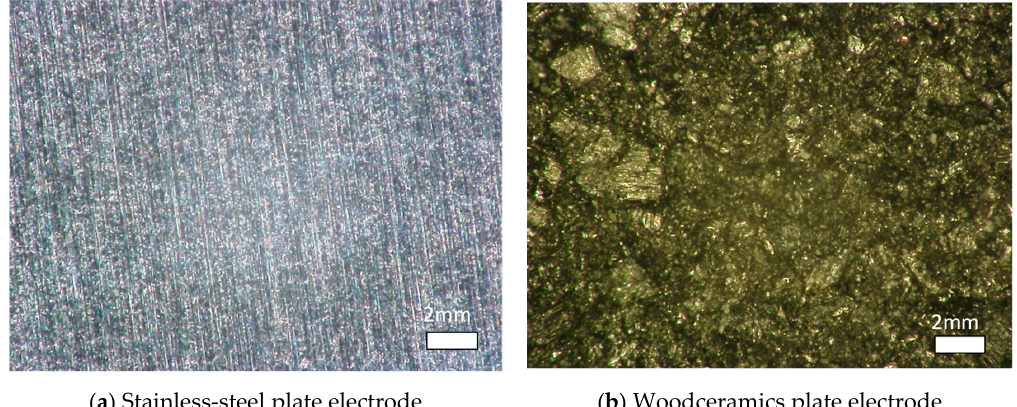
Figure 6. ( a ) Stainless-steel surface and ( b ) woodceramic surface. On the stainless-steel surface, the marks of the grinder are seen. On the woodceramic surface, the wood fiber appears dotted.